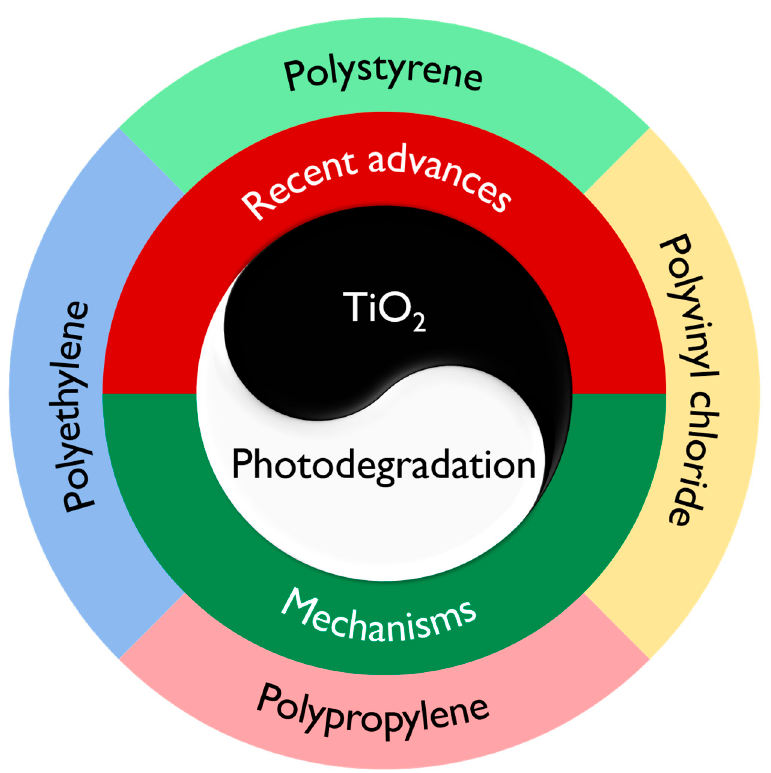
Figure 1. Focus of this review on catalytic photodegradation for various types of plastic polymers.